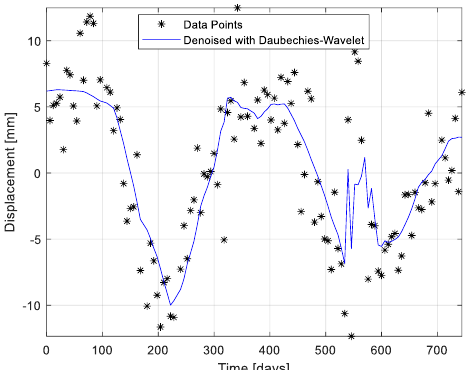
Figure 4. Original displacement time series of PS 1 (black stars) and the de-noised signal (blue).